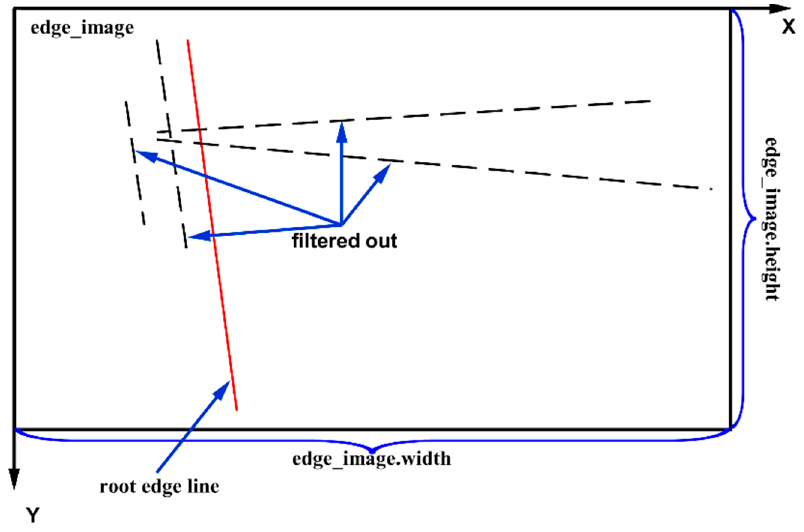
Figure 9. The process of screening straight lines.